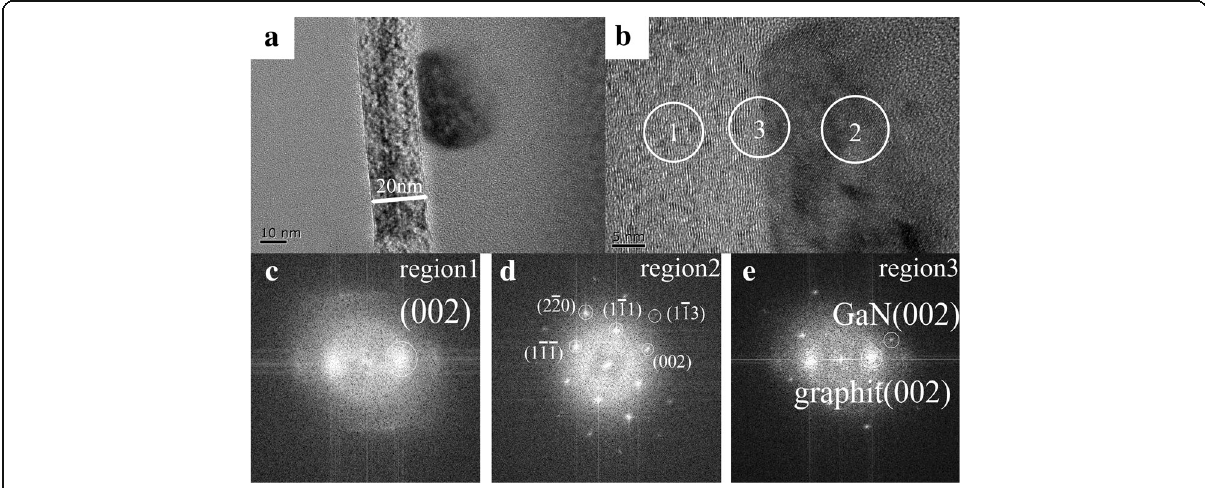
Fig. 3 a , b TEM and HR-TEM cross-section micrographs (along c-GaN [110]) showing the GaN and graphite interface. c – e Fourier transform diffraction patterns for graphite, GaN grains, and their interface,